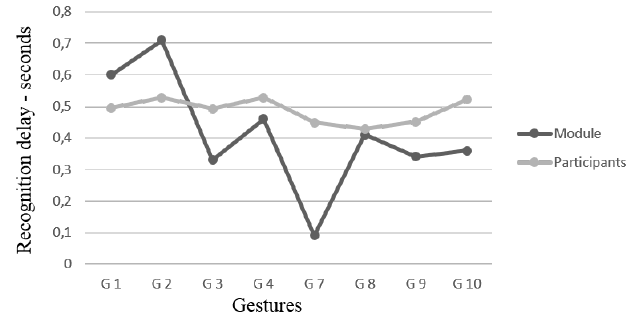
Fig. 5. Beginning detection delay in seconds. 0 corresponds to the expert annotation. Gestures G5 and G6 were deleted since mixed up by our module.